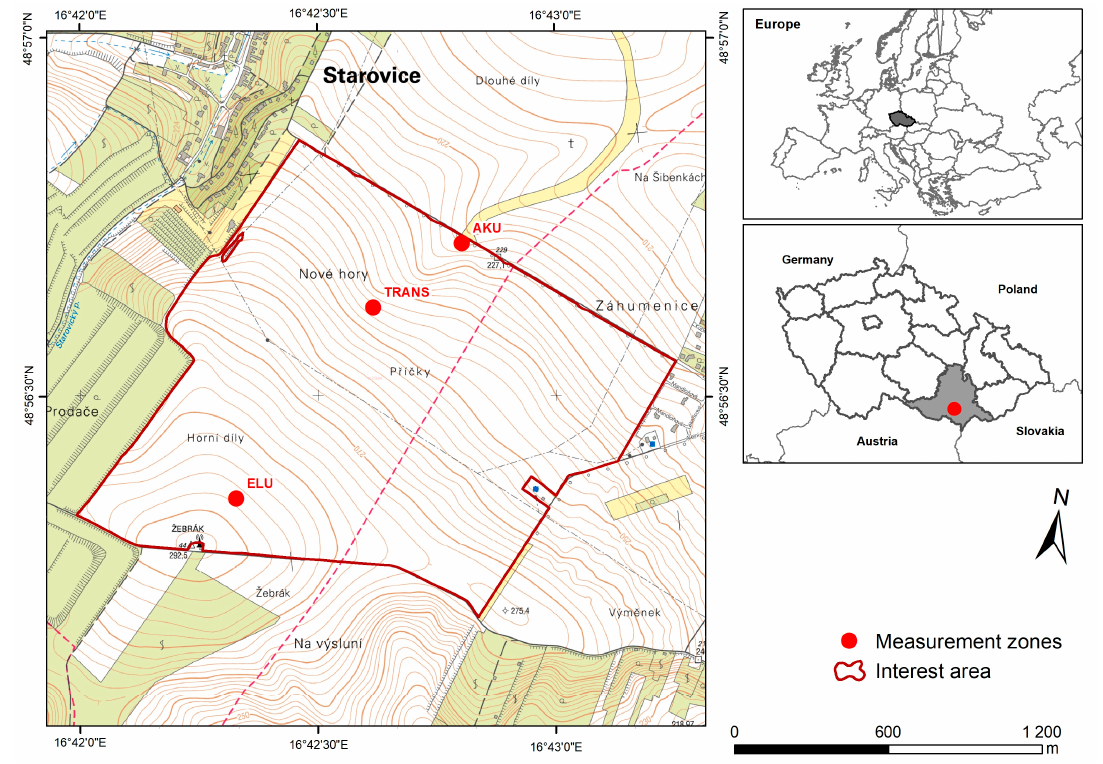
Figure 2. Measured points in Hustope č e.